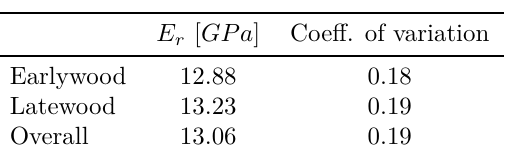
Table 1. Indentation